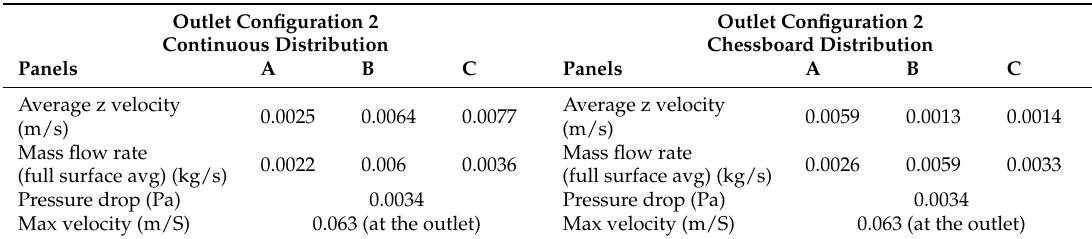
Table 4. Calculated quantities in the continuous and chessboard distributions for Outlet Configuration